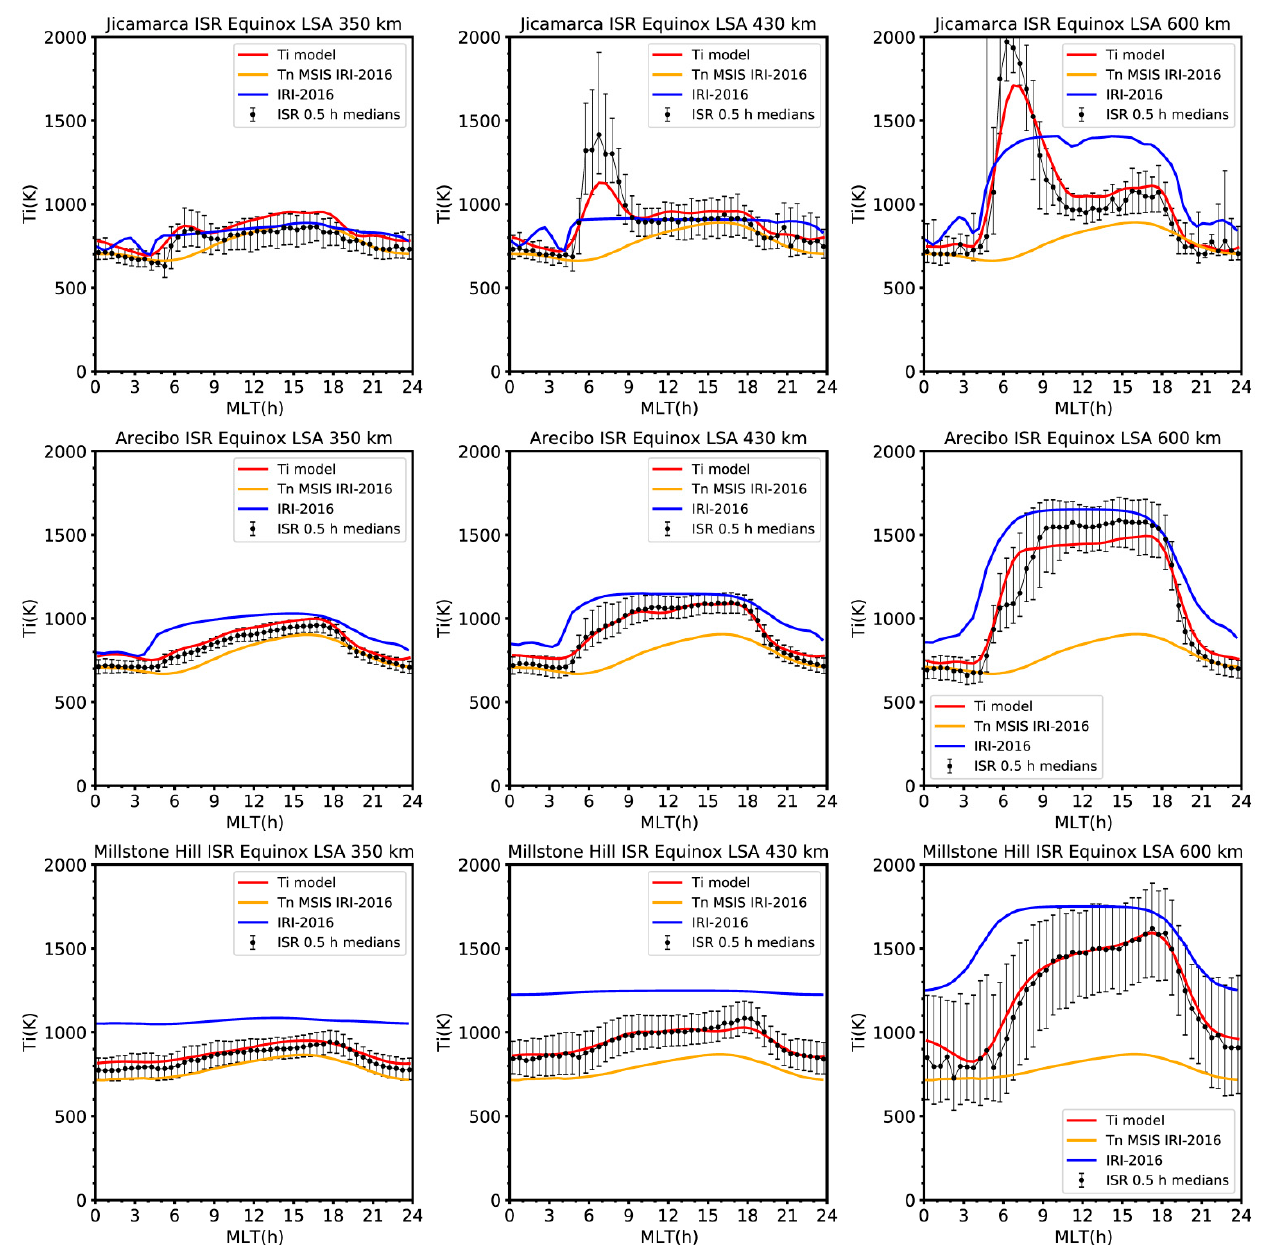
Figure 7. Local time variation of Ti for low solar activity (PF10.7 = 82.5) from the three ISRs (black circles—medians, error bars—upper/lower quartile; Jicamarca—upper row, Arecibo—middle row, Millstone Hill—lower row) and for three altitudes (350 km—left column, 430 km—middle column, 600 km—right column). Included is the proposed Ti model (red line), the IRI-2016 Ti model (blue line), and Tn from the IRI-2016/NRLMSISE-00 model (orange line).